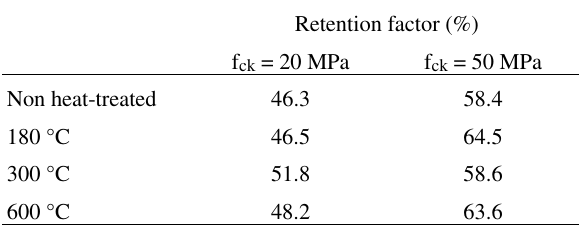
Table 5. Retention factor obtained from mercury intrusion porosimetry.